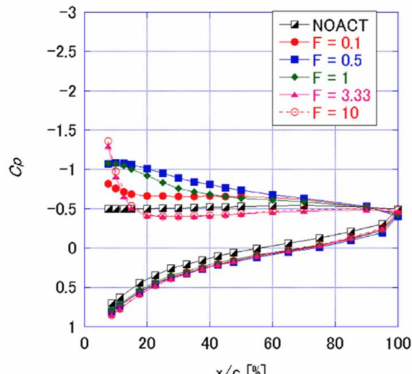
Figure 12. Chordwise C p distributions (Experiment): NACA0015, α = 22.0 ◦ , Re = 7.6 × 10 5 , BR = 10%. DBD plasma actuator is located at 5% of the chord, Vpp = 9